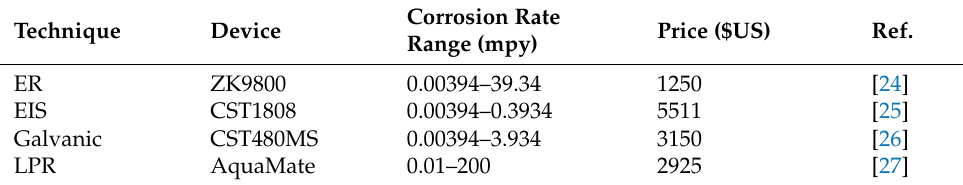
Table 2. List of commercial corrosion sensors in the market for real-time